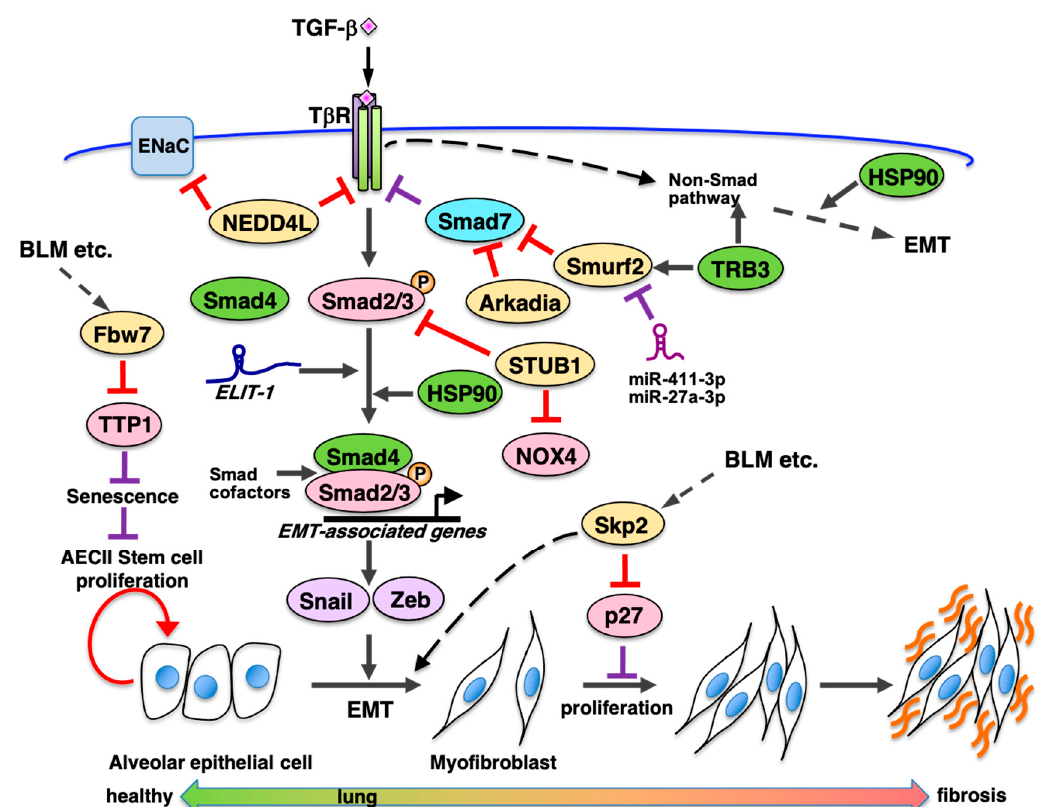
Figure 3. Possible modulators of fibrosis via regulating TGF- β signaling and cell proliferation. TGF- β signaling promotes induction of epithelial–mesenchymal transition (EMT) and expression of fibrosis-associated genes via TGF- β -Smad-dependent canonical pathway and non-Smad pathway. In the canonical pathway, TGF- β binds to and activates its receptor complex and promotes phosphorylation of Smad2/3. Then activated Smad2/3 forms a complex with Smad4 and the complex binds to the promoter regions of target genes associated with EMT and fibrosis. Inhibitory Smad such as Smad7 and Smad cofactors to regulate the TGF- β -Smad pathway. MiRNA such as miR-21 inhibits translation of Smad7 as a positive regulator of TGF- β signaling. Several lncRNAs participate in controlling TGF- β -mediated EMT and/or fibrosis. A lncRNA ELIT-1 which is induced by TGF- β -Smad pathway binds to Smad3 to facilitate recruitment to promoters of Smad target genes promoting EMT as a Smad cofactor. Moreover, several E3 ubiquitin ligases are involved in promotion in pulmonary fibrosis. Skp2 which promotes p27 degradation is involved in promotion of EMT and mesenchymal fibroblast proliferation. Fbw7 which participates in TPP1 degradation promotes alveolar epithelial stem cell senescence and pulmonary fibrosis. Abbreviations and details of each molecule are indicated in the text.